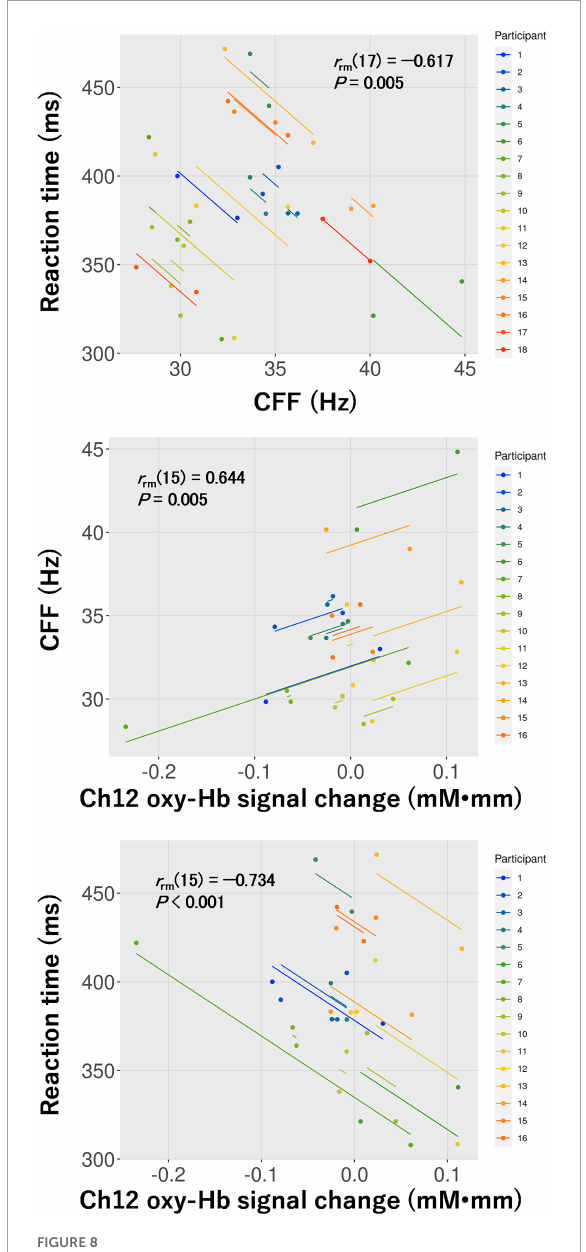
FIGURE8 Repeated measures correlations between critical flicker fusion frequency (CFF) and the reaction time for the visual task (top: n = 18), CFF and hemoglobin concentration changes (oxy-Hb signal change) in ch12 (middle: n = 16), and the reaction time for the visual task and oxy-Hb signal change in ch12 (bottom: n = 16) in the 3D